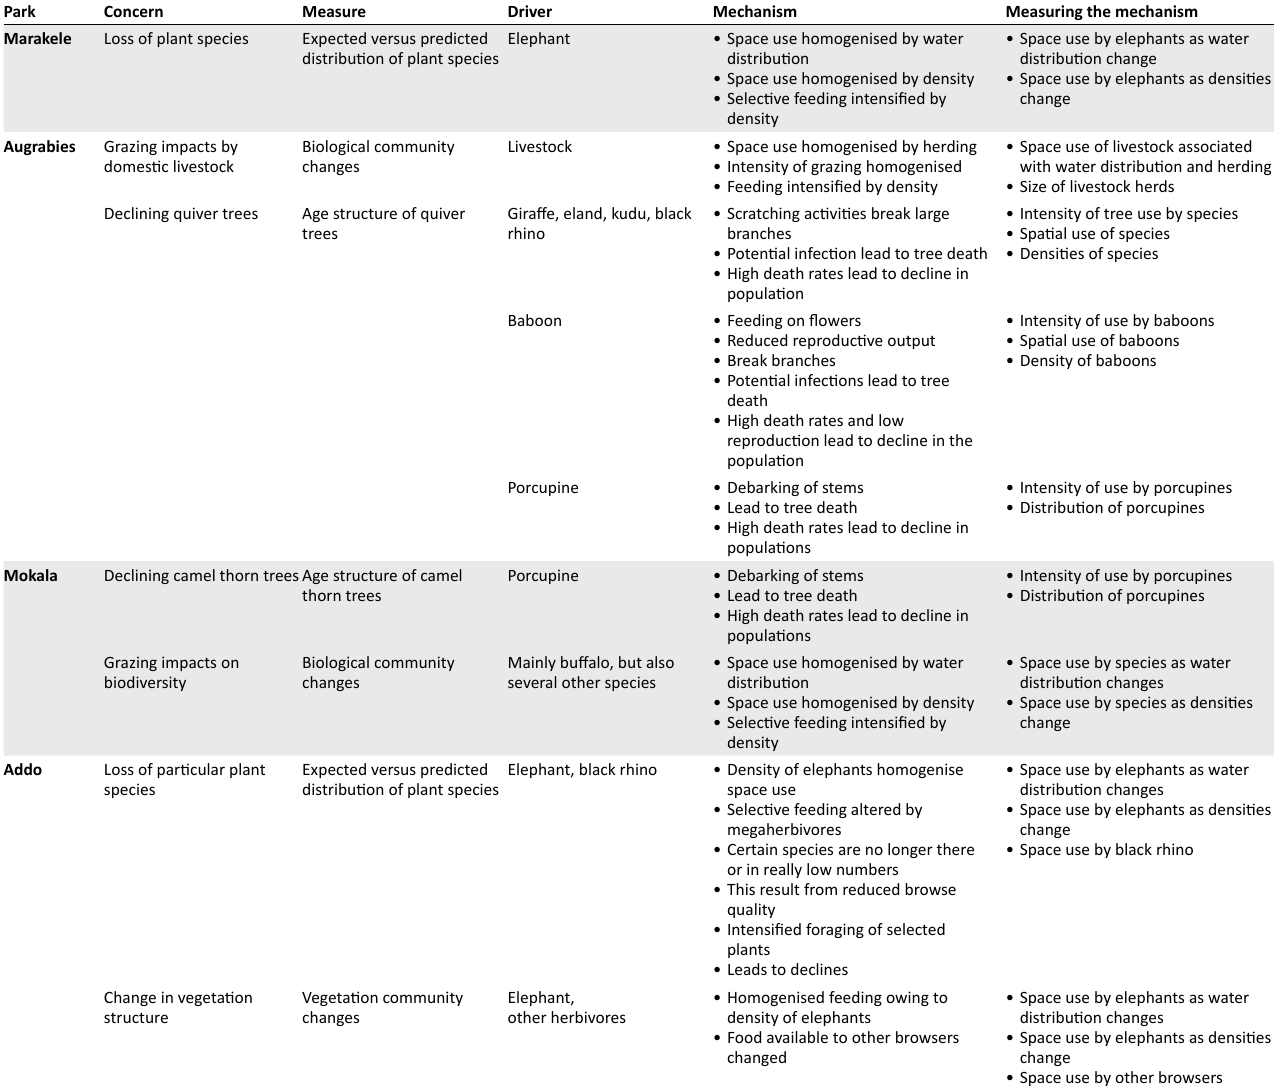
TABLE 4: Herbivory concerns unpacked across selected parks managed by SANParks, to illustrate how monitoring needs driven by linkages to objectives, mechanisms and modulators require a spectrum of monitoring information, but also many commonalities (SANParks unpublished records). Park